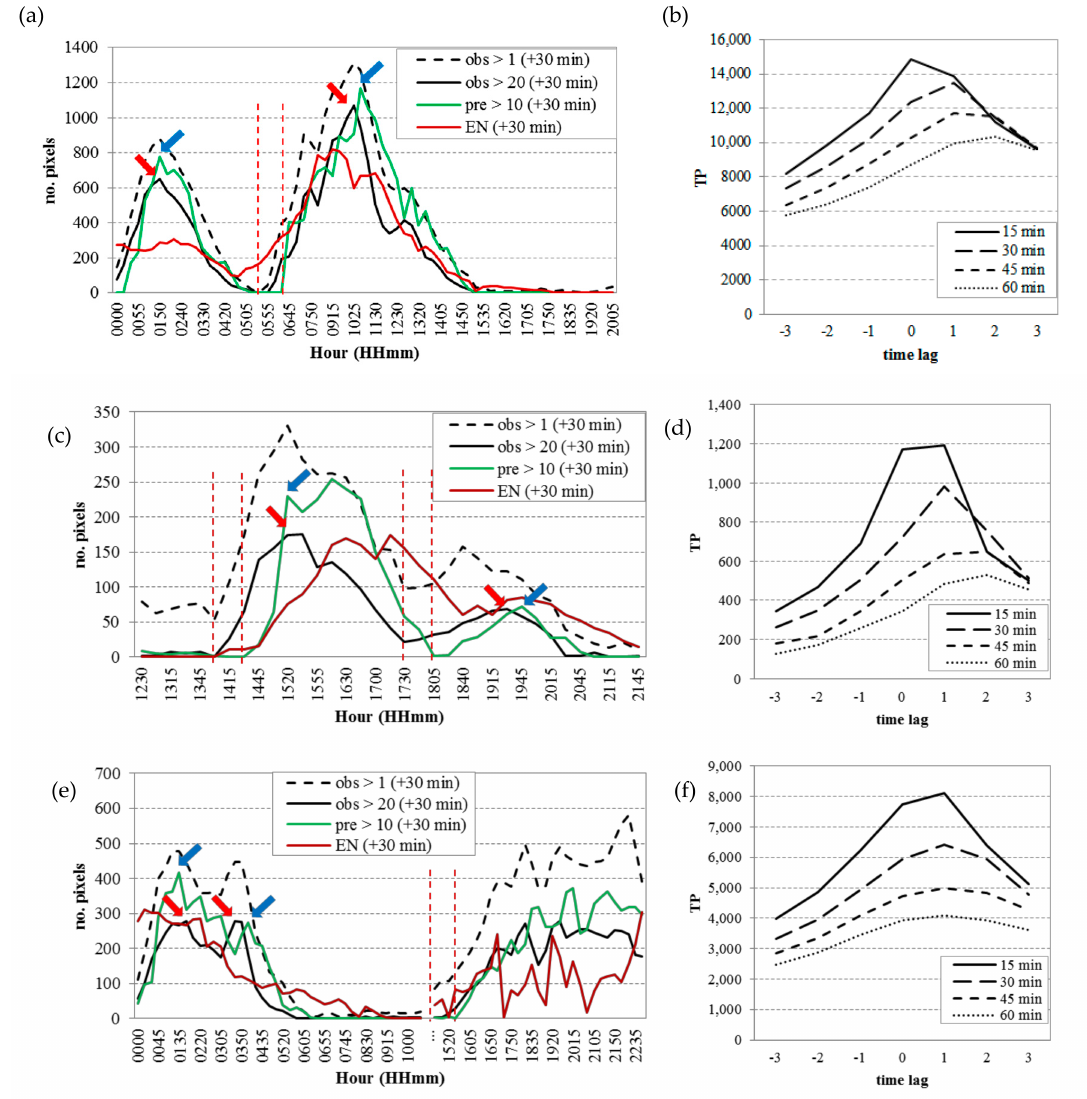
Figure 7. Time series of the number of pixels per image according to the thresholds established in the legend (for 30-min prediction) and time lag ( × 15 min) of TP events up to 60 min lead time forecast for each case study: ( a ) and ( b ) 31 July 2018, ( c ) and ( d ) 5 December 2018, ( e ) and ( f ) 22 December 2018. The arrows mark the delays between the observed (red) and predicted (blue) number of pixel peaks. The vertical red dashed lines mark the observed and predicted “rain